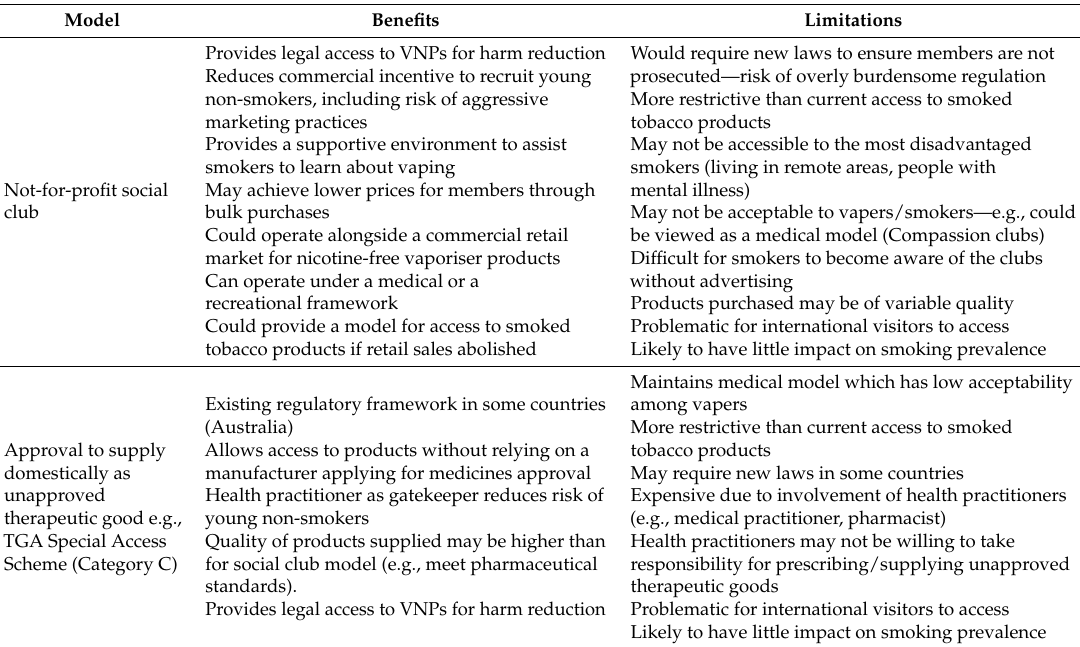
Table 2. Benefits and limitations of social club and special access scheme